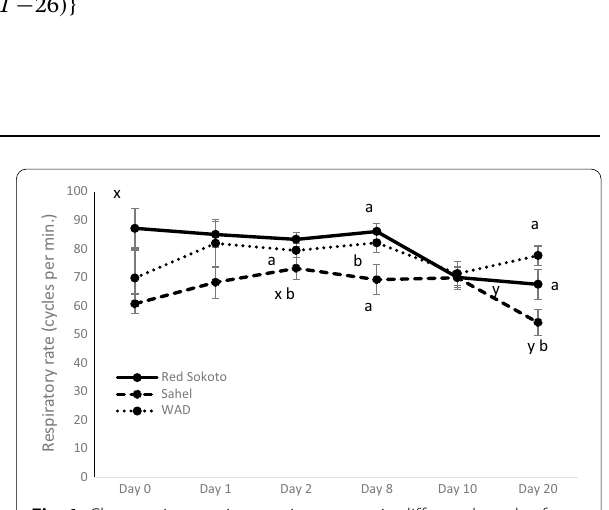
Fig. 1 Changes in morning respiratory rate in different breeds of neonatal Nigerian goats from birth to Day 20. Values with a , b and x , y indicate significantly different ( P < 0.05) between different breeds and